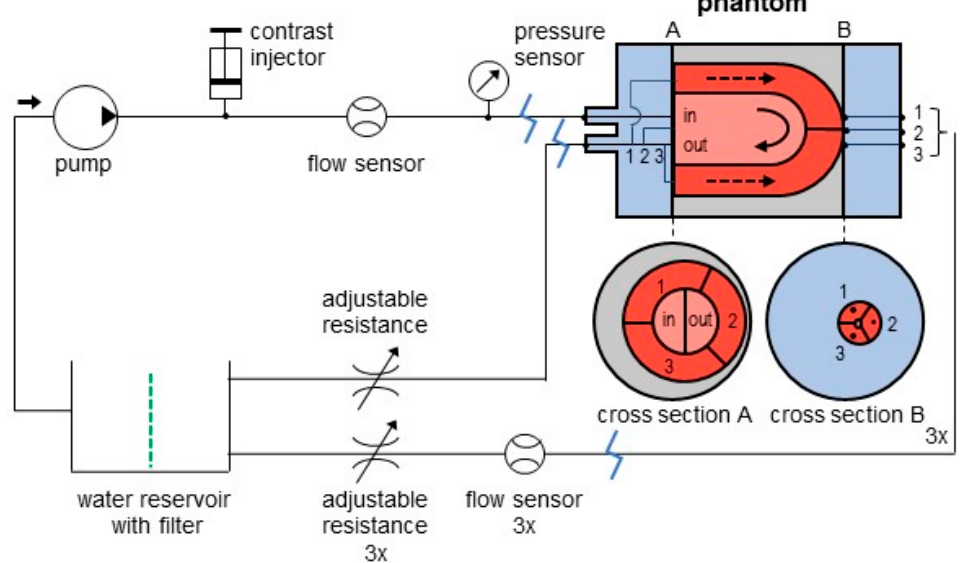
Figure 2. Flow circuit design of the standard phantom setup. The 3D printed phantom cylinder exists of one inlet to the simulated left ventricular cavity. Its main outlet (mimicking the aorta) branches to three identical surrounding myocardial regions (1 ‒ 3). Each region has an individual outlet. All flow circuit components are connected by silicon tubing. Modality-specific adjustments incorporate a custom-built filter in the water reservoir to adsorb recirculating radiotracer during SPECT and PET measurements (dashed green line) and additional tubing of 8 m was built in at the in blue marked positions for MRI measurements. The arrow in the left top indicates flow